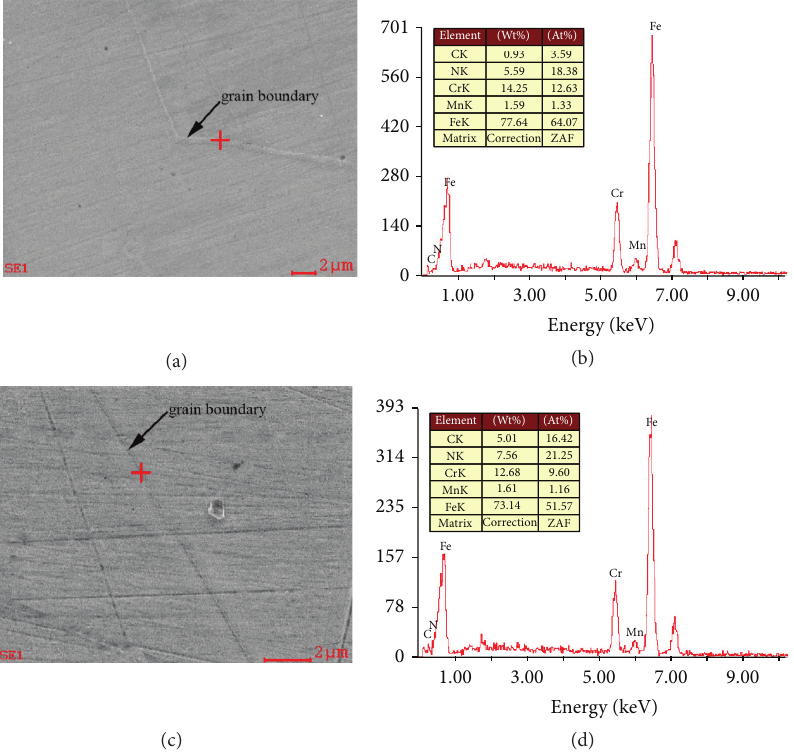
Figure 7: SEM micrographs and EDS analysis results along the grain boundary in FSS 429. (a) Solution specimen, (b) EDS spectra of grain boundary in (a), (c) the specimen aged at 550 ∘ C for 1h, and (d) EDS spectra of grain boundary in (d).